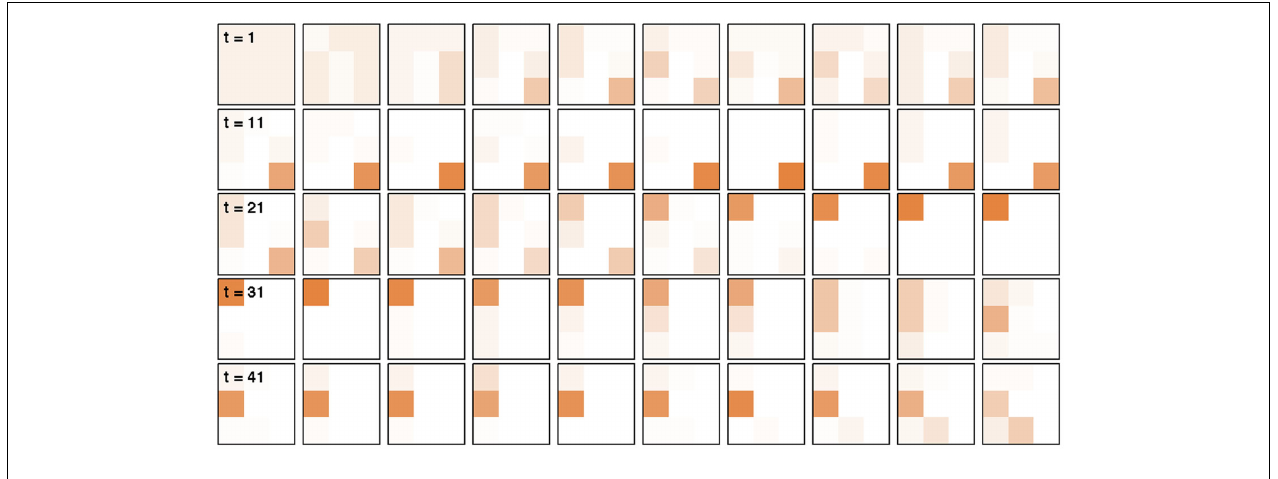
right corner.There are two unsignaled change-points in this data set, on trials 15 and 30.The model requires quite a few trials to detect the change (and the resulting drop from 75% chance of reward to 42%), but does so